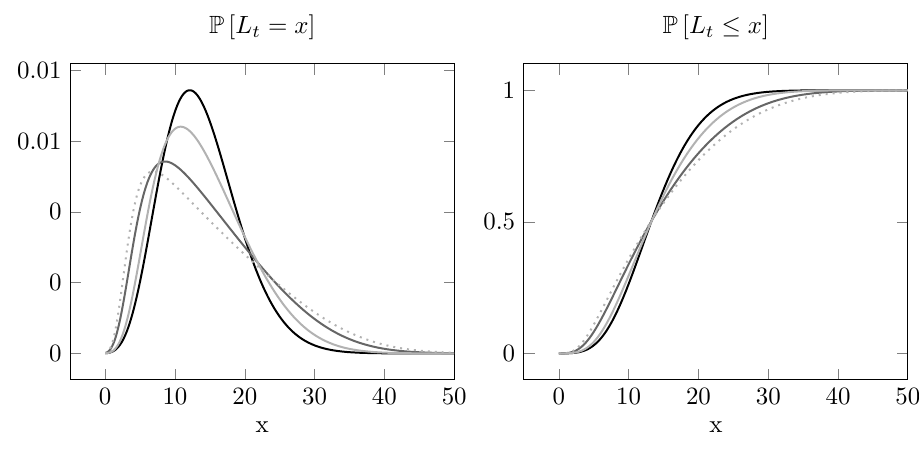
Figure 5: Loss distribution and loss amounts dependence. Theprobability(left)andcumulative(right)densityfunctionsofthelossdistributionaredisplayedforthreedifferentlossamounts specifications. With a standard one-factor copula model with parameter equal to 0.25, constant marginal default intensity λ 0.05, and a 5-year horizon we consider the linear Beta-Binomial loss amounts with m 1 = m 3 and m 2 = m 4 for the values: m 1 = 1 and m 2 = 0 (black line), m 1 = 1 and m 2 = 1 (grey line), m 1 = 3 and m 2 = 1 (light-grey line), and m 1 = 3 and m 2 = 5 (dotted light-grey line).